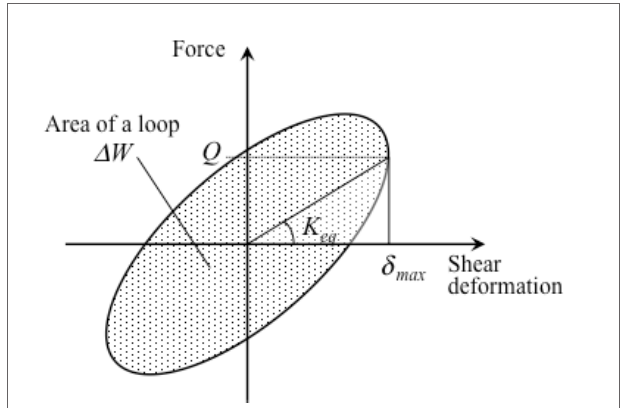
FIGURE 5 | Evaluation of equivalent stiffness and area of a hysteresis loop .